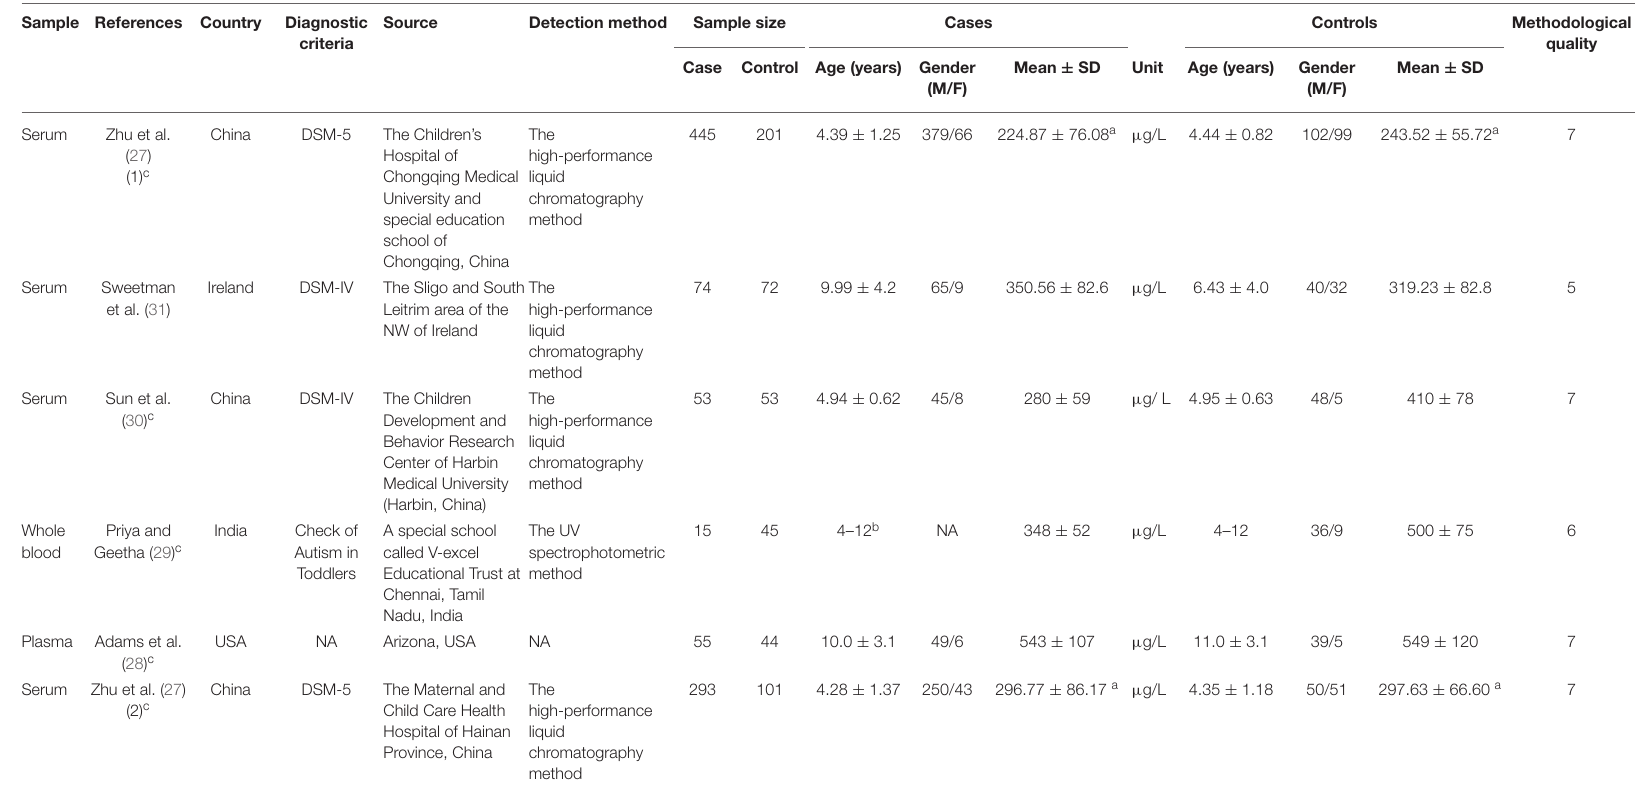
TABLE 1 | Characteristics of the studies included in the